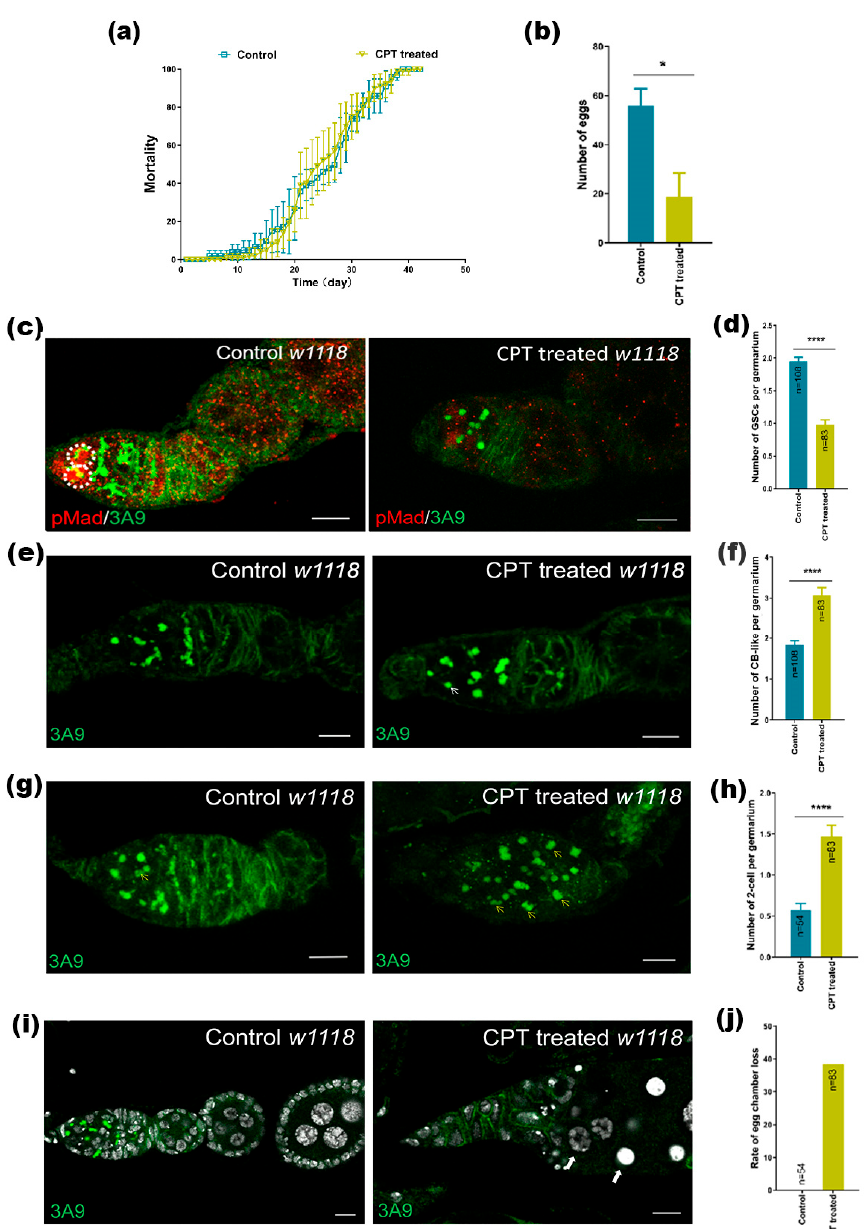
Figure 1. The effects of CPT on germ cells. ( a ) The mortality of flies after the flies were treated by CPT. ( b ) The number of eggs laid at the 9th d post CPT or DMSO solution treatment. ( c ) GSCs stained with anti-pMad and anti-3A9 antibodies in germarium at the 9th day post CPT or DMSO treatment. GSCs were indicated by white dashed circle. ( d ) Statistical data showing the GSC number from control and treated groups. ( e ) Germ cells stained with anti-3A9 antibody in germarium at the 9th day post CPT or DMSO treatment. CB-like cells were indicated by white arrow. ( f ) Statistical data showing the CB number from control and treated groups. ( g ) Representative DMSO- and CPT-treated images showing the effect of CPT on two-cell stained with anti-3A9. two-cell was indicated by yellow arrow. ( h ) Statistical data showing the two-cell number from control and treated groups. ( i ) Representative control and CPT-treated images showing CPT treatment blocked germ cell differentiation leading to accumulation of CB and two-cells and stained by Hoechst (white) and 3A9 (green). The white arrow indicated egg chamber loss. ( j ) The number of egg chambers showing abnormal phenotype, including apparent failure of egg chamber budding leading to empty egg chamber. Values are the means ( ± SEs) of replicates. Statistical comparisons were based on Students’ s t -tests. The level of significance for the results was set at * p < 0.05, **** p < 0.0001. Scale bar, 10 µ